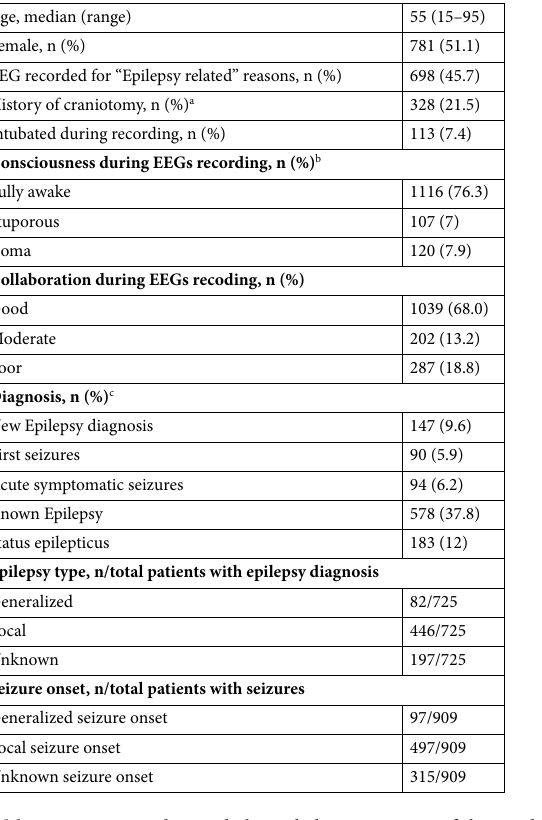
Table 1. Demographic and clinical characteristics of the total EEG cohort (n = 1528). a One patient with missing data. b Two patients with missing data. c One EEG recording can be related to several